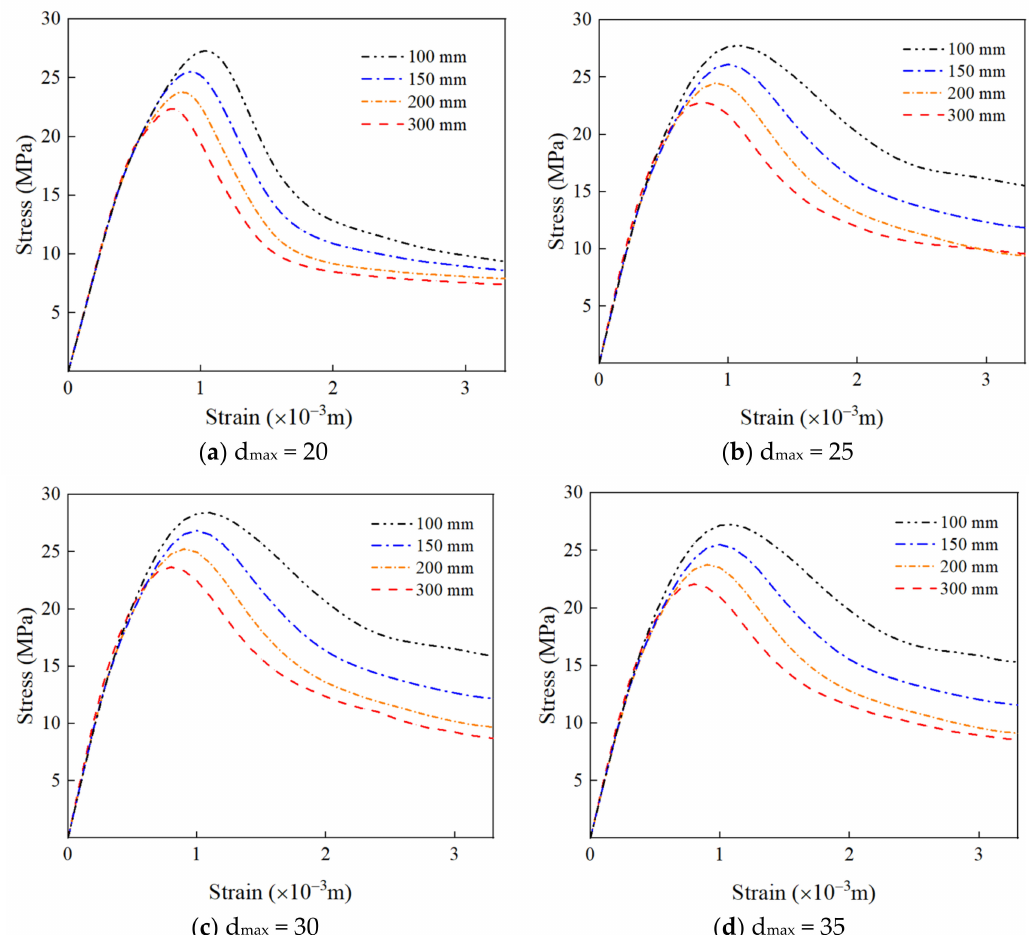
Figure 19. The stress–strain curve of RAC under different